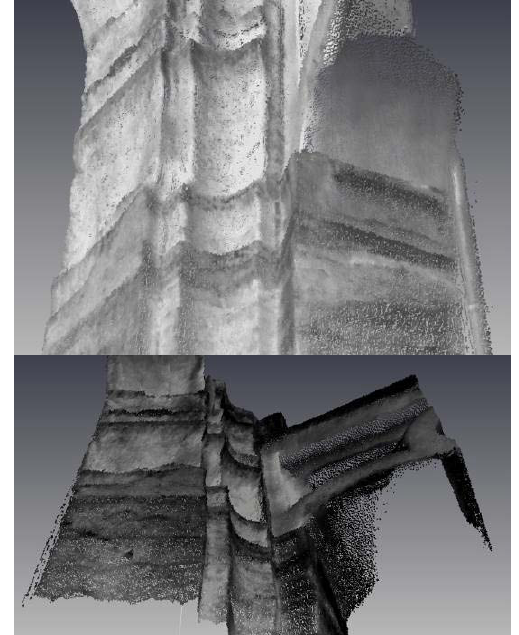
Figure 5: Examples of low quality point scan due to the marble surface inside the spire’s helicoidal staircase.